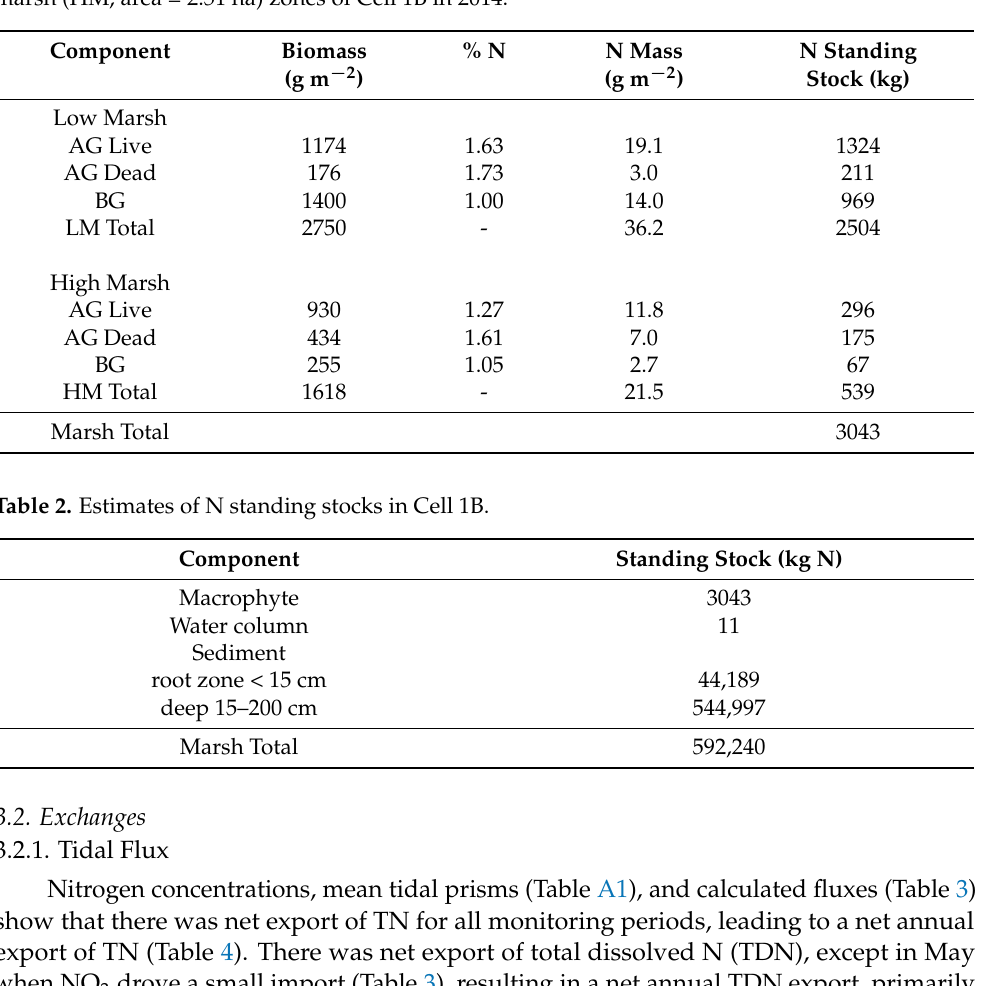
Table 1. End of season biomass and N standing stocks for low marsh (LM, area = 6.92 ha) and high marsh (HM, area = 2.51 ha) zones of Cell 1B in 2014.